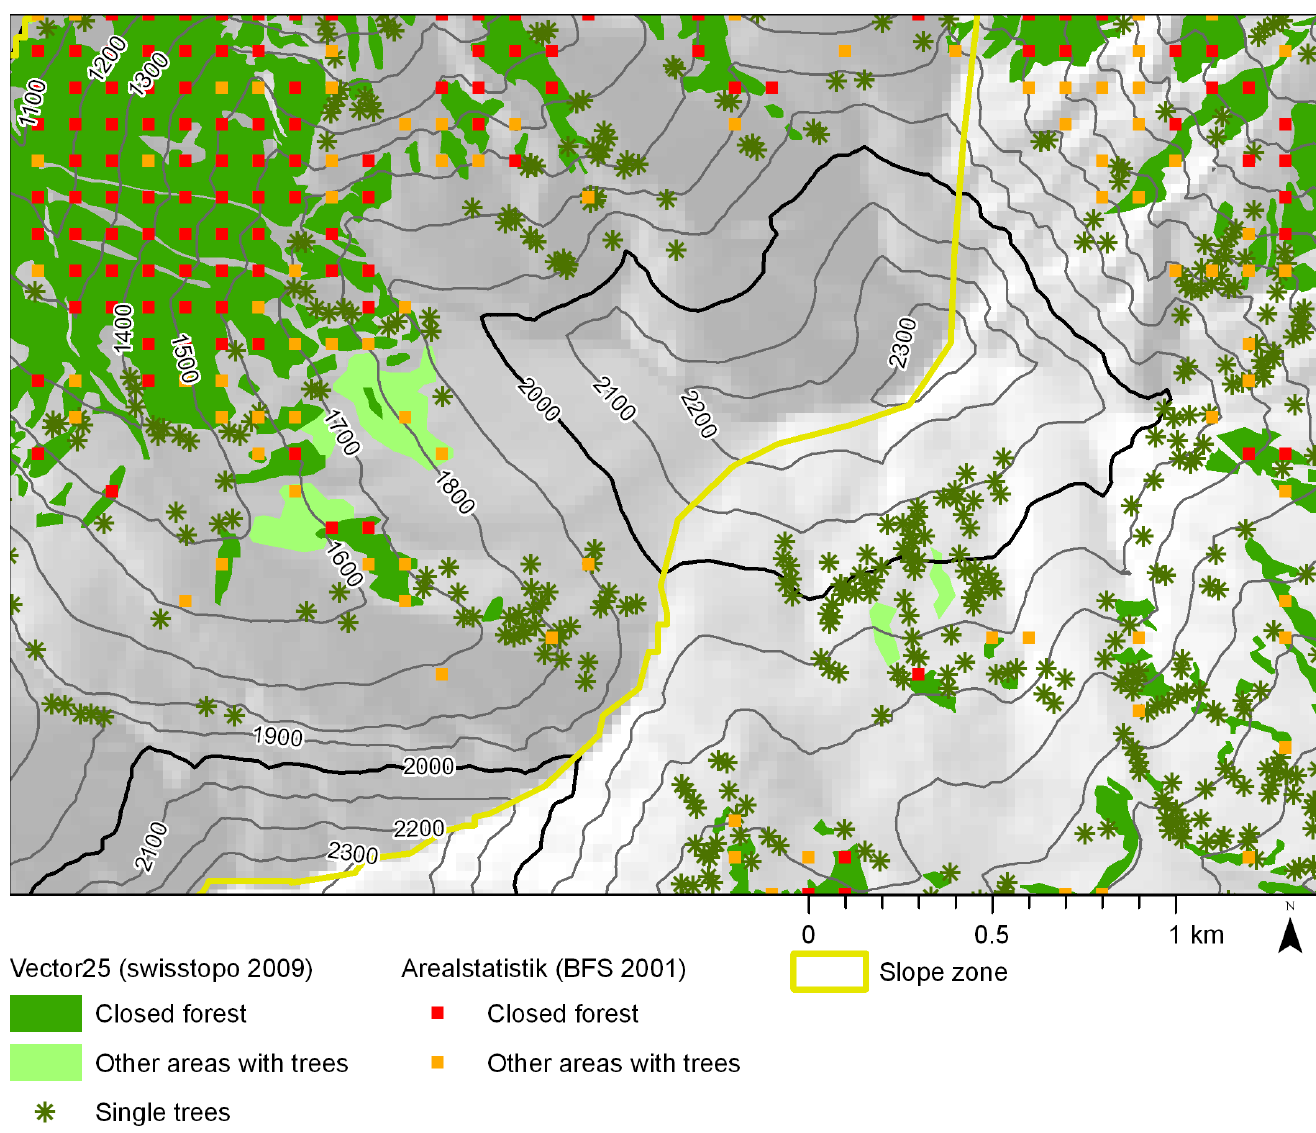
Figure 3. The map shows the forest dataset and the tree dataset according to the sources Arealstatistik 1992-1997 (BFS 2001) and Vector25 (Swisstopo 2009). The yellow line is the boundary of the slope zones which served as spatial reference units for the analysis. The map encloses the Niesen (2362 m), the first peak of an elongated ridge in the